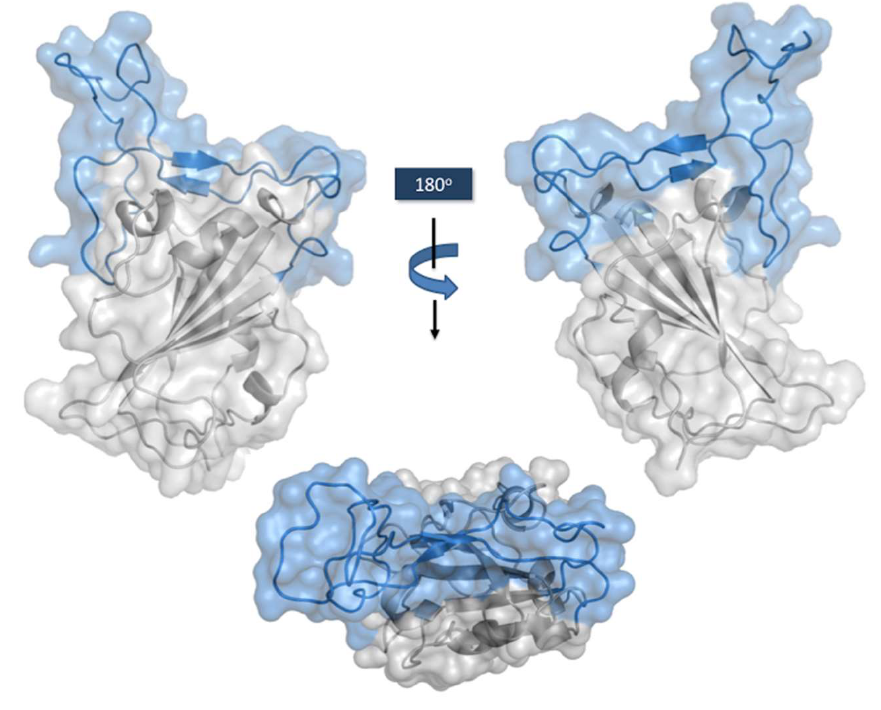
Figure 4. Connolly surface of the RBD with RBM motif in light blue. Side views on the top. RBM seen from the hACE-2 perspective on the bottom. The figure was generated using the coordinates with PDB ID: 7MZG in PyMOL Molecular Graphics System version 2.4.1. Schrödinger, LLC, New York (https://pymol.org/2, accessed on 16 May).